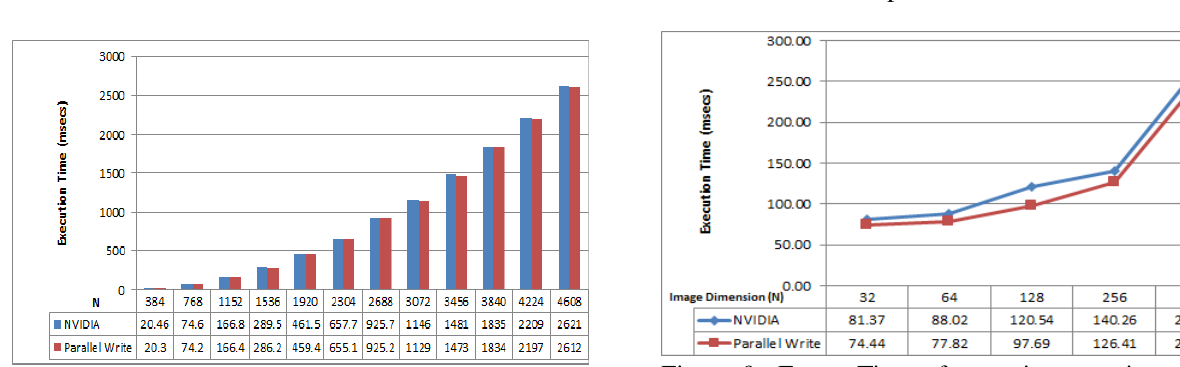
Figure 8: Exec. time with Tile Size = 32 x 32 and Thread Block Size = 32 x 32